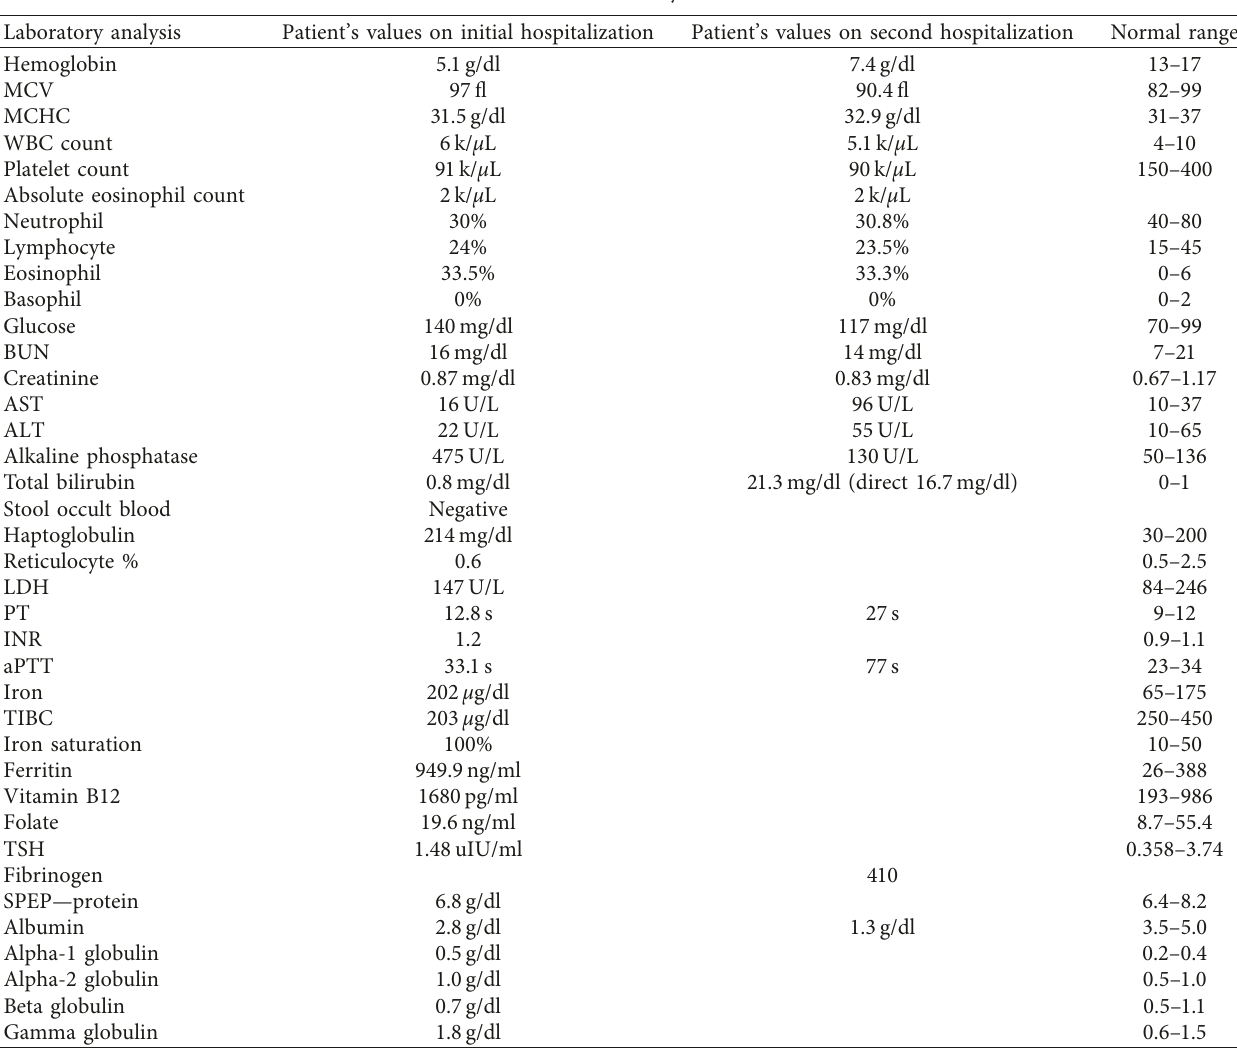
Table 1: Laboratory values.